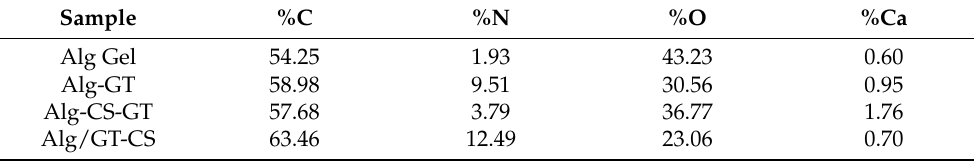
Figure 2. ( A ) XPS spectra of (a) Alg/GT-CS, (b) ALG-GT, (c) ALG-CS-GT and (d) Alg Gel, and ( B ) ( B ) N1s spectra peak of ALG-CS-GT and their fitting curves. N1s spectra peak of ALG-CS-GT and their fitting curves. Table 2. XPS elemental analysis results for Alg Gel, ALG-GT, ALG-CS-GT and Alg/GT-CS. Table 2. XPS elemental analysis results for Alg Gel, ALG-GT, ALG-CS-GT and